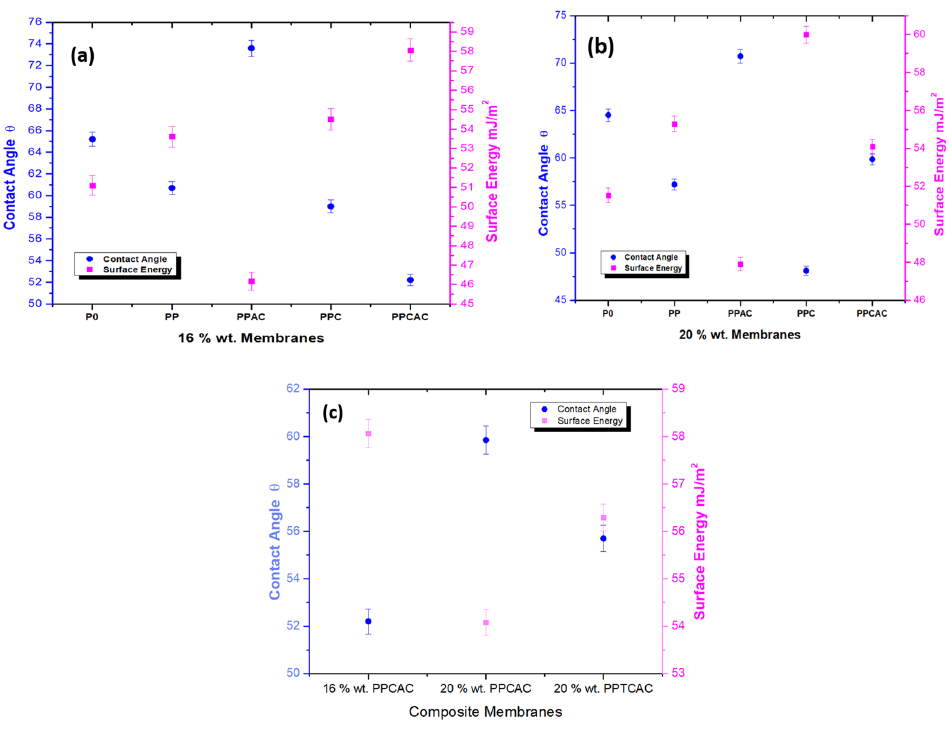
Figure 5. Contact angle vs. surface energy for ( a ) 16% wt. membranes, ( b ) 20% wt. membranes and ( c ) composite membranes.